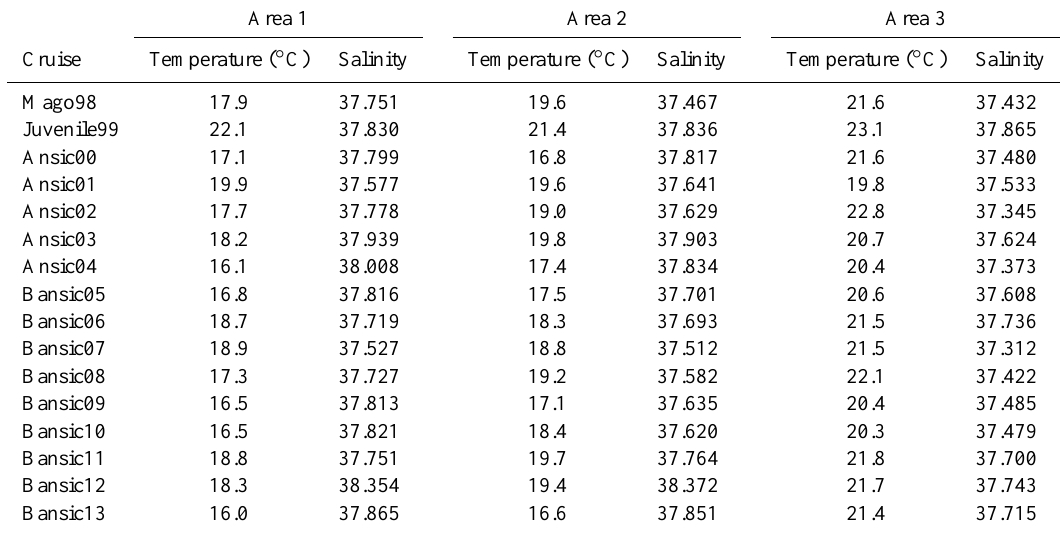
Table 3. Mean temperature and salinity in the coastal upwelling region (areas 1 and 2) and in the control one (area